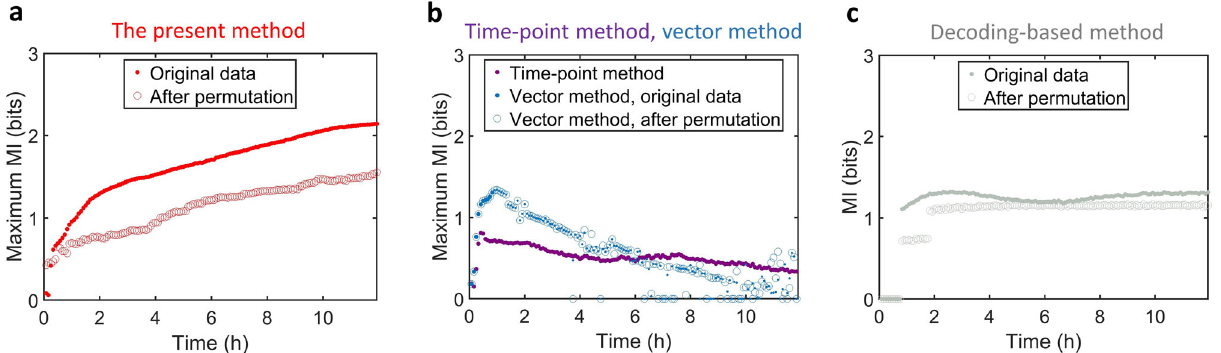
Fig. 3 Dynamical mutual information and comparison with the previous approaches. We used all the 13 different stimulus conditions to calculate the mutual information. a The maximum dMI increases with time and is diminished when timepoints are randomly shuf fl ed. To be consistent with other MI measures, all y -axis of the maximum dMI is labeled as “ Maximum MI. ” b The timepoint method 18 and the vector method 27 do not capture information in the full signaling trajectory. The vector method suggests that mutual information decreases after around 10 timepoints, while the trajectory ensembles retain substantial differences, and is independent of the ordering of timepoints. c The decoding-based method 28 (using the fi rst ten principle components) provides a lower bound on mutual information ( y -axis is “ MI ” without “ Maximum ” ) and does not reveal how mutual information accumulates over time. The random permutation of timepoints does not dramatically affect the saturated value. Source data are provided as a Source Data fi le.